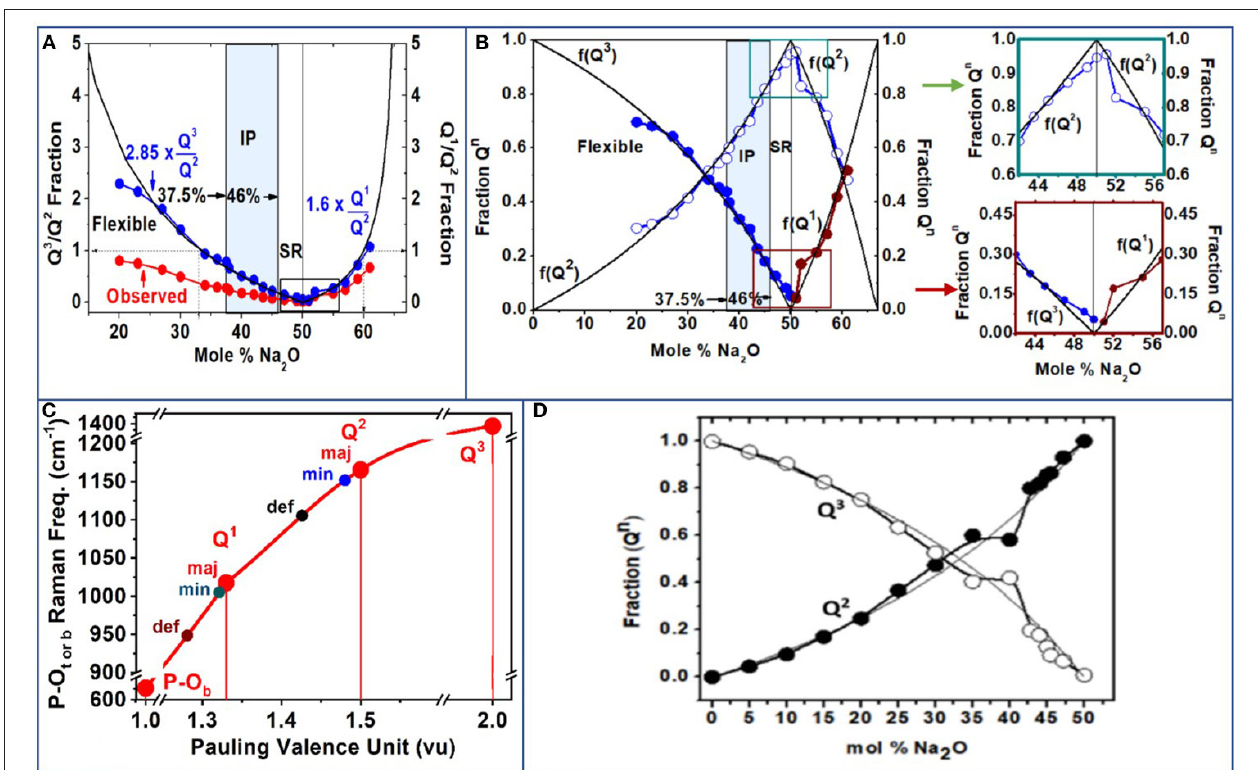
FIGURE 12 | (A) Observed Q 3 /Q 2 fractions and Q 1 /Q 2 fractions (red data points) obtained from Raman scattering features 1, 3, and 4 ( Figures 8 , 9 , 11 ). The blue data points are obtained after the Raman scattering strengths are corrected for Raman cross sections (see text). (B) The f(Q 3 ) and f(Q 2 ) and f(Q 1 ) fractions are plotted as a function of x. The variations in the fractions f(Q 3 ) and f(Q 2 ) near x = 50% deviate measurably from the mean-field behavior as shown in the two insets of (B) . See text for details. (C) Raman P–O t mode frequency for the Q 3 species and the triad of Q 2 and Q 1 species as a function of Pauling valence unit (PVU). For completeness, we include Raman P–O b mode frequency with a PVU of 1. (D) Fractions of Q 2 and Q 3 species deduced from 31 P NMR results of Brow et al. (1994, 1995); Brow (2000)